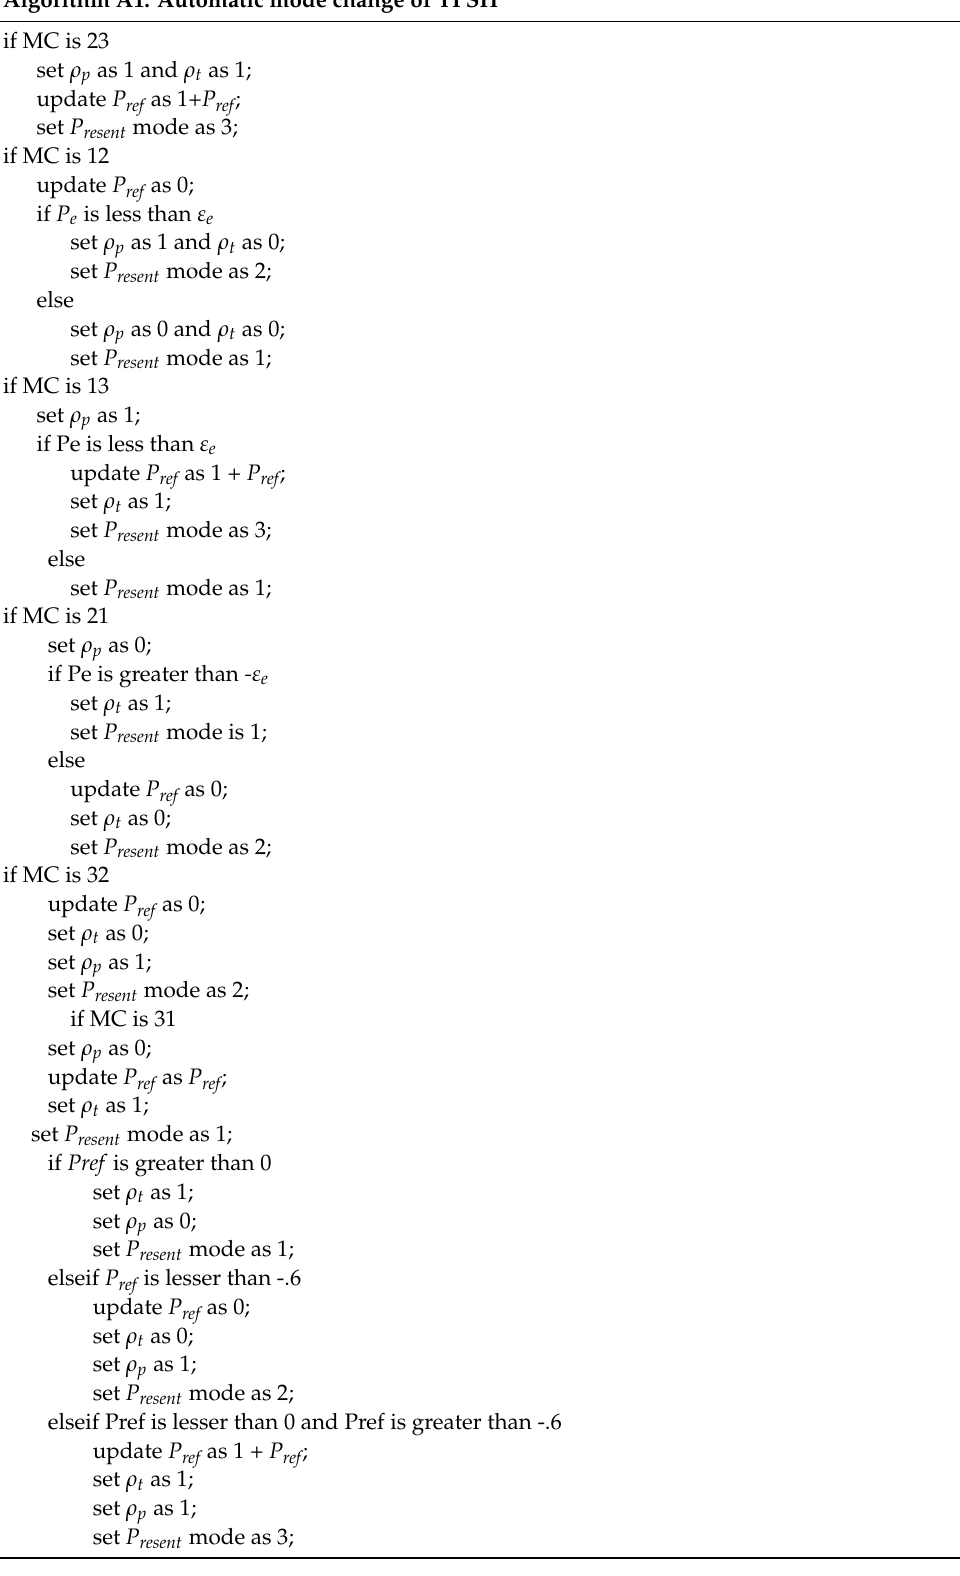
Algorithm A1. Automatic mode change of